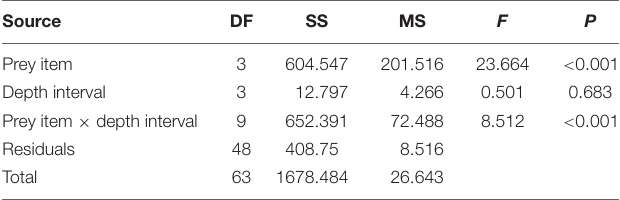
TABLE 2 | Results of two-way ANOVA with item prey and depth interval as fixed factors.